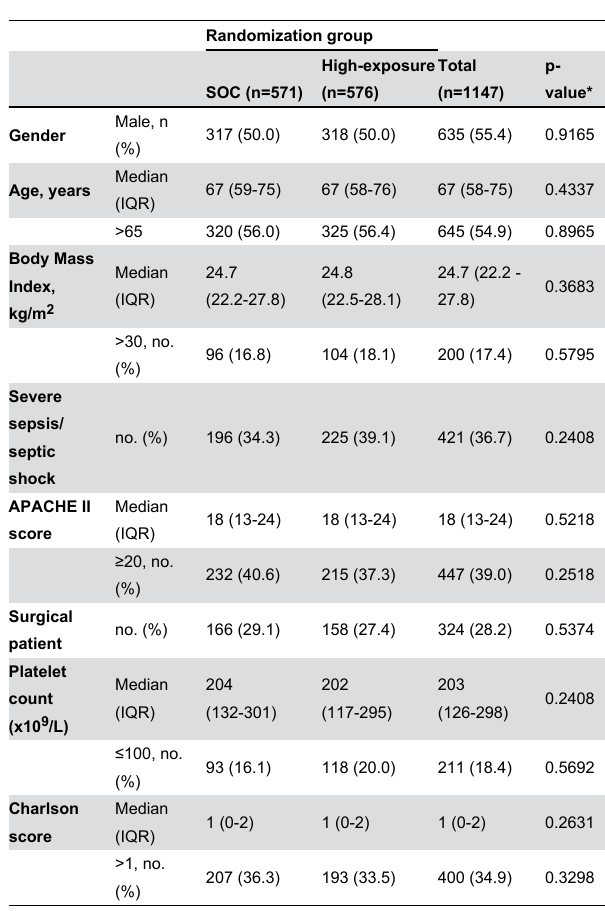
Table 1. Main characteristic at study